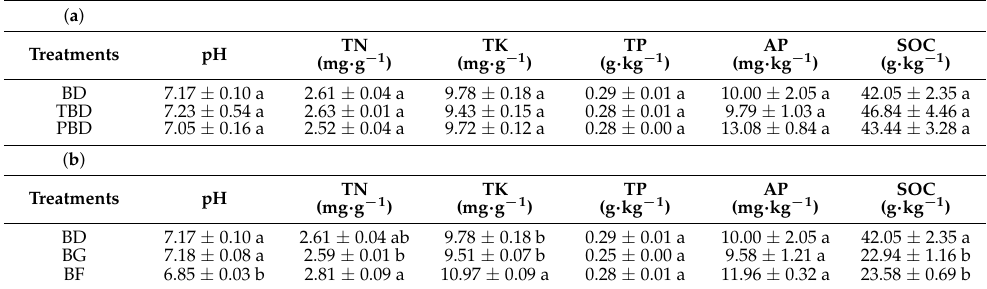
Table 1. Soil physicochemical parameters under different treatments. ( a ). Soil physicochemical pa- rameters under different cover crops–biochar–organic fertilizer treatments. ( b ). Soil physicochemical parameters under different biochar–organic fertilizer